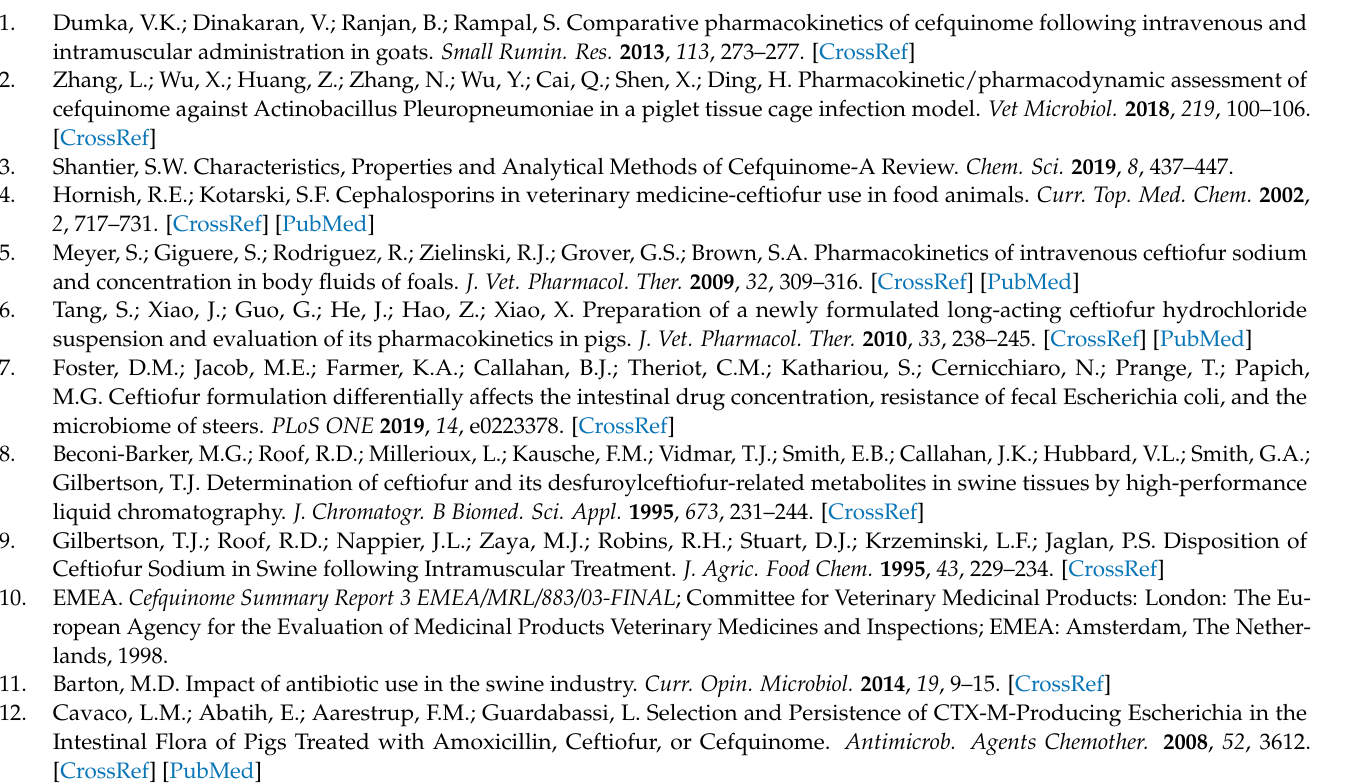
and MS/MS spectra, Figure S2: MS/MS chromatograms Table S1: Freeze-thaw, matrix and extract stability